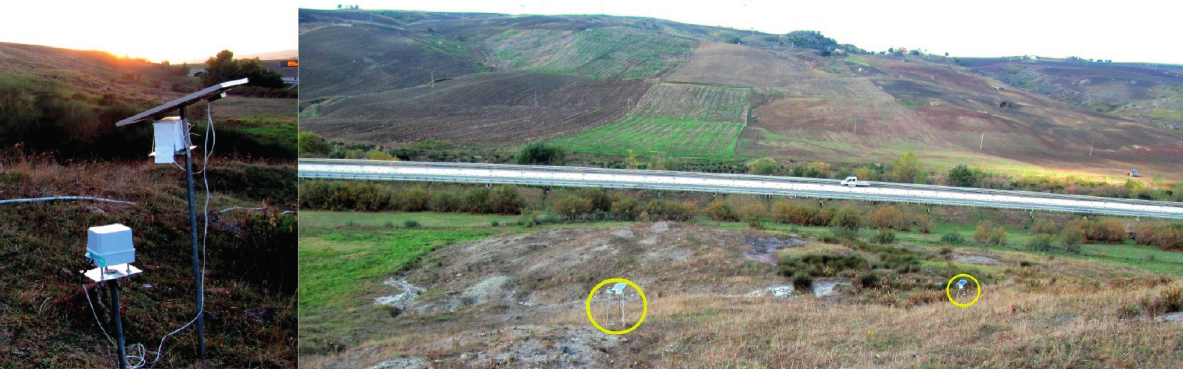
Figure 13. ( Left ) A POIS levelled and connected to the solar panel; ( Right ) Two sensors (yellow circles) on the toe of the monitored landslide, close to the A16 highway, near Lacedonia (Southern